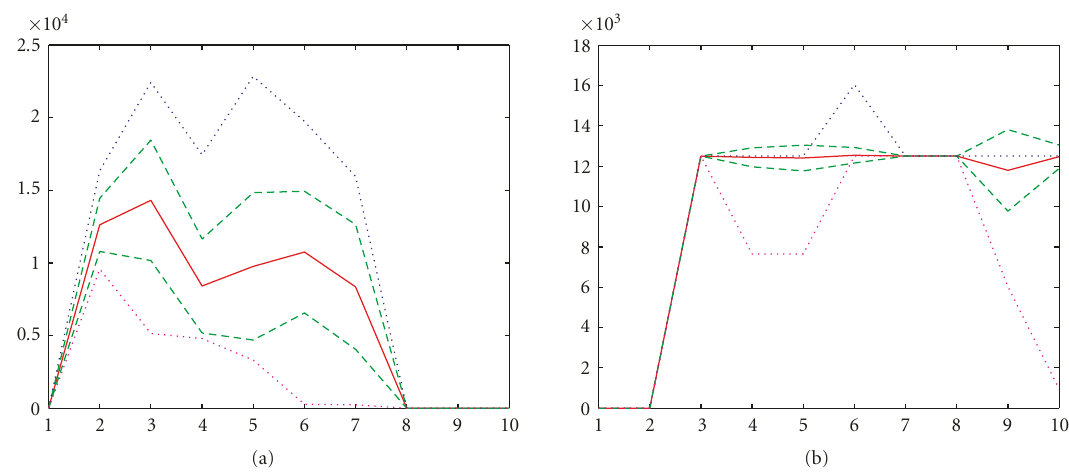
Figure 11: Absolute area error for the architecture without (a) and with (b) agent coordination.